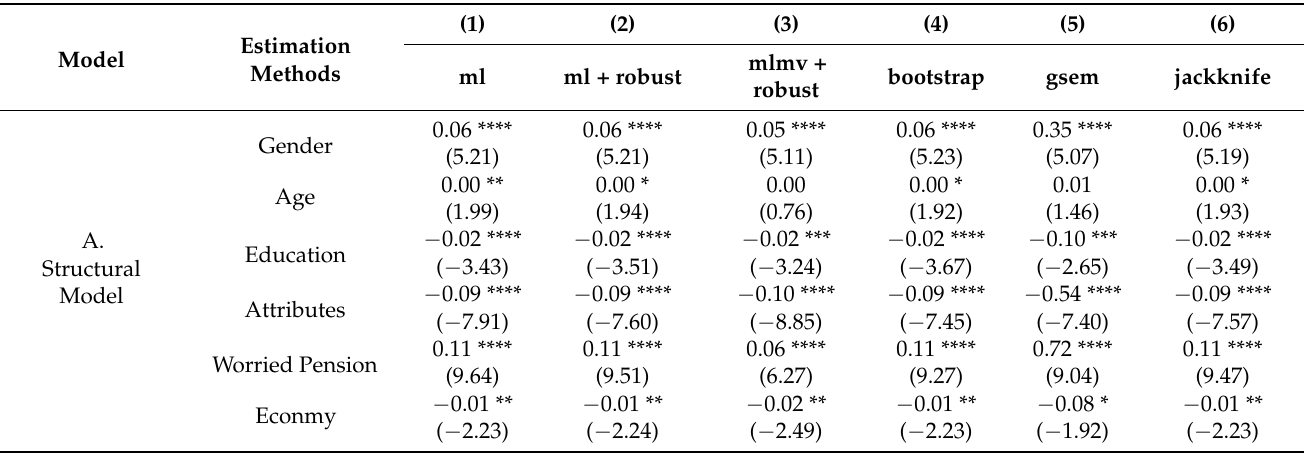
Table 3. Results of model regression of factors influencing the demand for care services for the